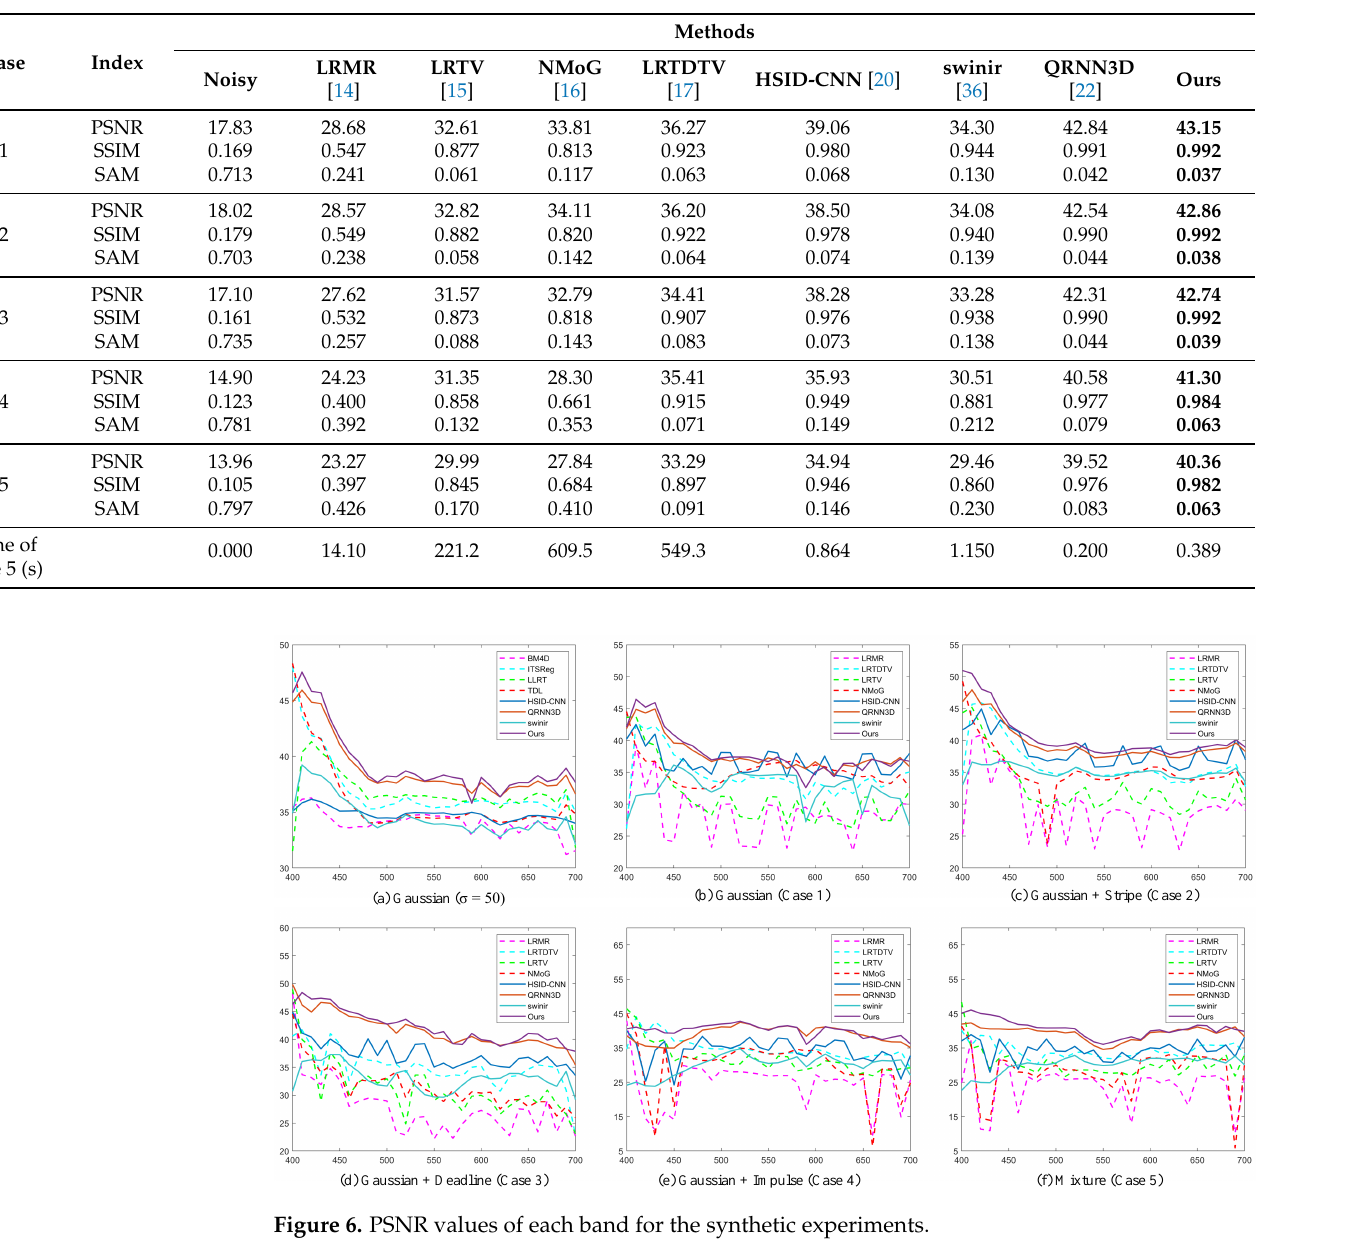
Table 3. The denoising results in the complex noise case on the ICVL dataset.